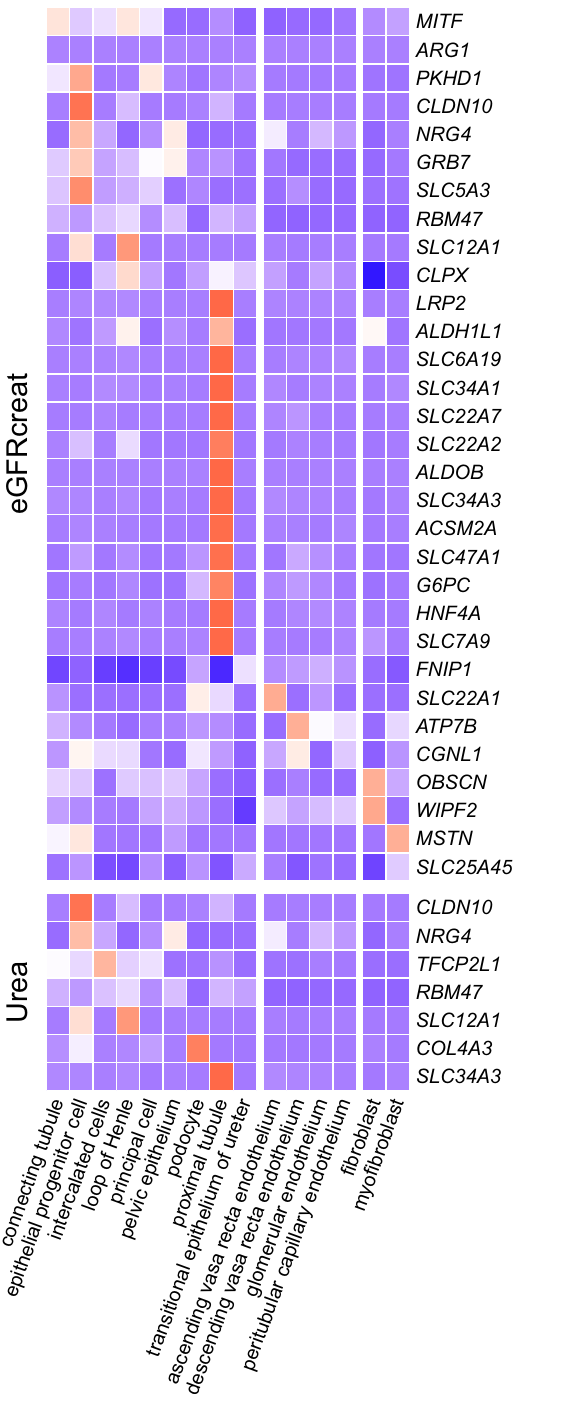
types are grouped into nephron, endothelium, and stroma, with 9, 4, and 2 cell typeseach.Genesineachheatmapareorderedbythemaximumexpression z -score along the 15 cell